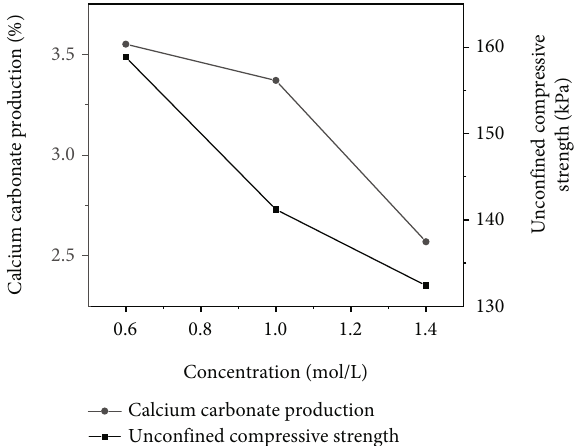
Figure 13: Comparison of calcium carbonate formation and uncon fi ned strengths of calcium acetate-cured samples.